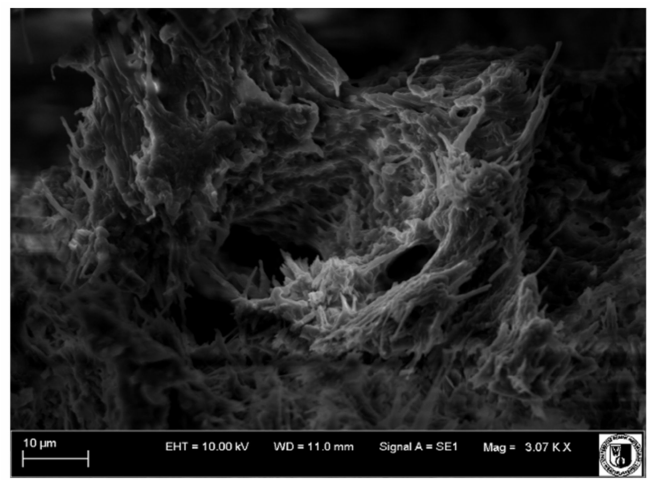
Figure 21. Scanning electron microscope image, human molar—Group III. Delaminated, oedematous blood vessels (arrow). 3000 × .